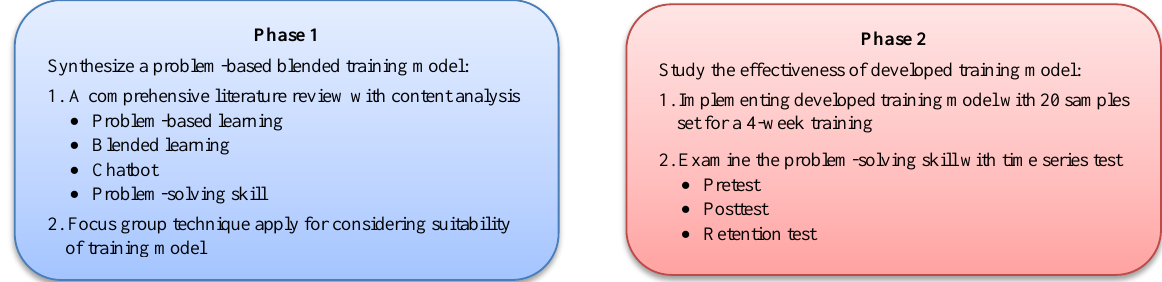
Figure 1. Research framework of problem-based blended training via chatbot to enhance problem-solving skills in the workplace